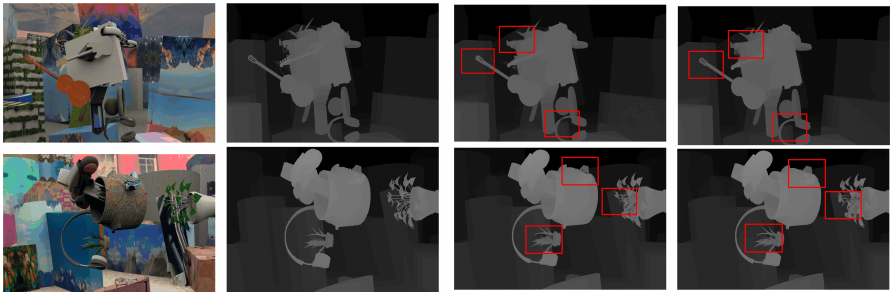
Figure 8. Visualization results on the Scene Flow dataset. The red box represents the comparison between MCAFNet and AANet+. The first column is the original map, the second column is the true value map of disparity, the third column is the predicted disparity map of AANet+ and the fourth column is the predicted disparity map of MCAFNet.